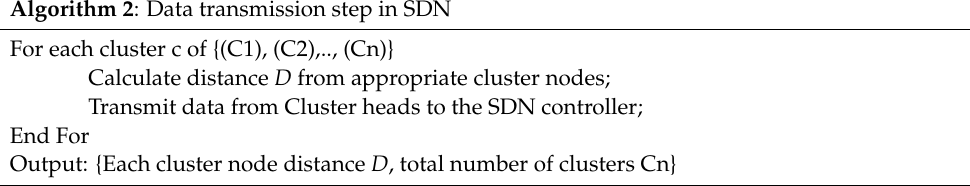
Algorithm 2 : Data transmission step in